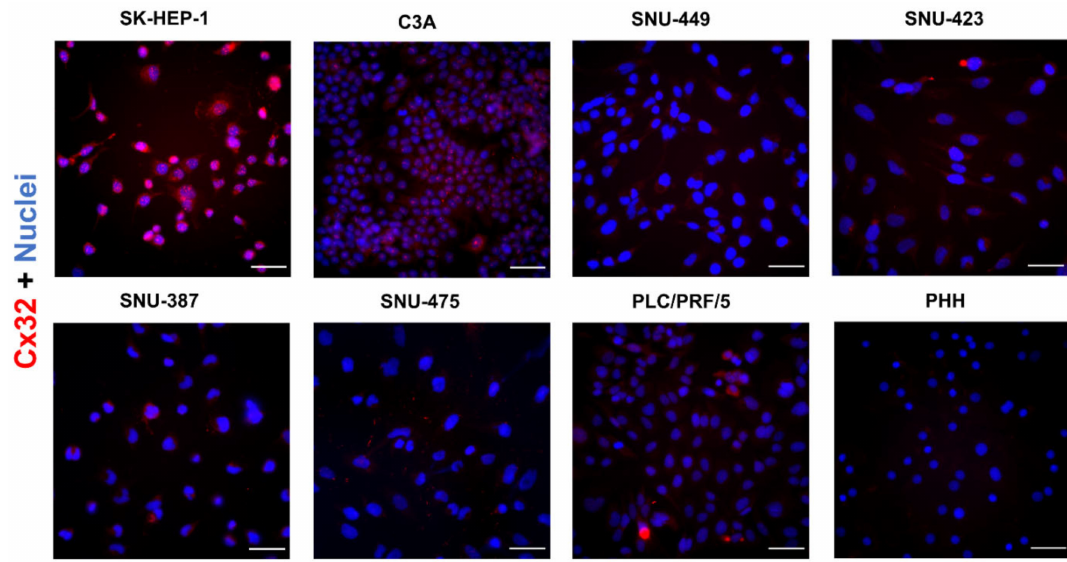
Figure 5. Cx32 protein localization in liver cancer cell lines and primary human hepatocytes (PHH). Cancer cell lines ( n = 1, N = 2) were fixed during the exponential growth phase, while PHH were fixed at the final day of the sandwich cultivation period. All cells were immunostained for Cx32 (red) with nuclear counterstaining using 4 (cid:48) ,6-diamidino-2-phenylindole (DAPI) (blue). Scale bar = 50 µ m. Images were taken with a 40 × objective. A representative image is shown.